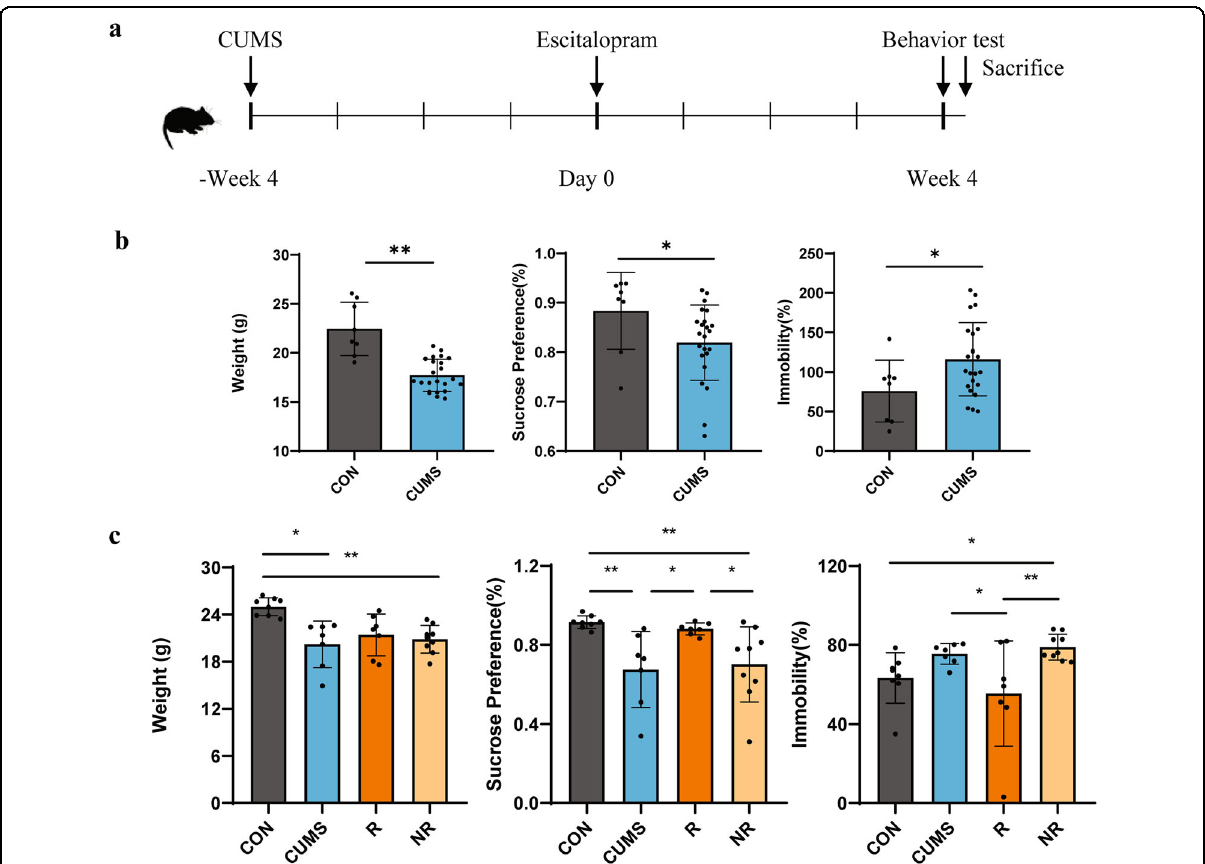
Fig. 1 Schematic of experimental protocols and procedures and behavioral results. a Flow diagram of experiment. Analysis of weight, sucrose preference in SPT and immobility (%) in FST of the mice after 4 weeks of CUMS ( b ) and 4 weeks of escitalopram administration ( c ). (* p < 0.05, ** p < 0.01, One-way analysis of variance). FST, forced swim test. SPT, sucrose preference